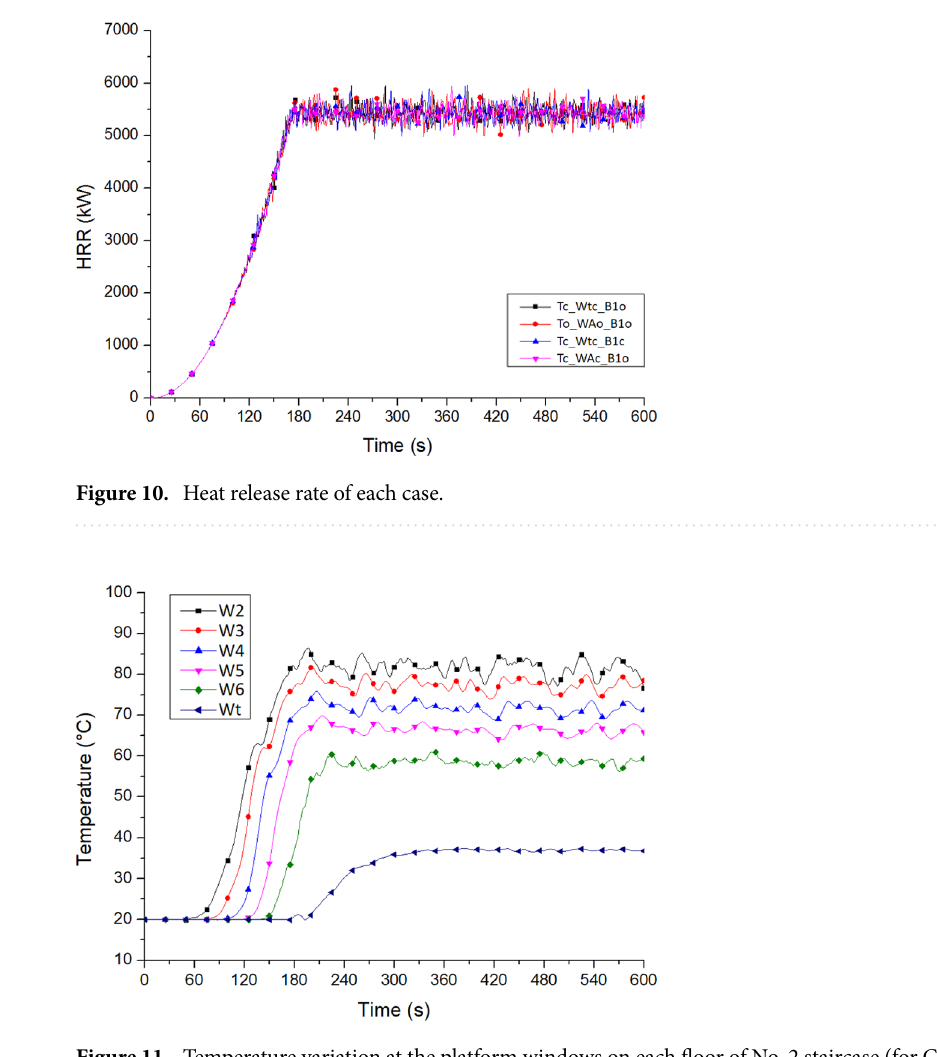
Figure 11. Temperature variation at the platform windows on each floor of No. 2 staircase (for Case Tc_Wtc_ B1o).